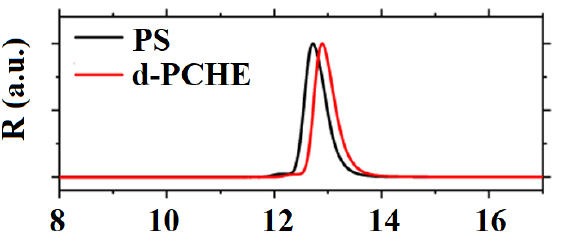
Figure 10. Size exclusion chromatograms before (black curves) and after (red curves) hydrogenolysis with deuterium exchange (PtRe/SiO 2 catalyst to PS at 1:1 (w/w) loading, 17 h, 170 °C). PS (black curve) was fully saturated, forming PCHE (red curve) before and after the reaction. Reprinted with permission from ref. [41].